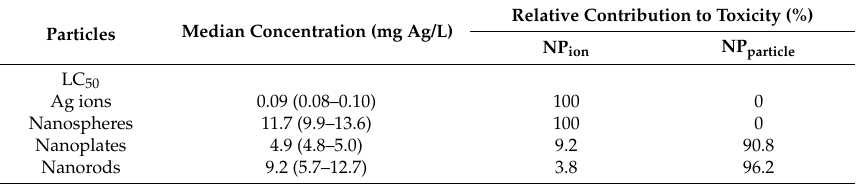
Table 2. Relative contribution (%) of AgNP ion and AgNP particle to toxicity at the LC 50 (lethality) level. LC 50 concentrations are presented as median concentration (95% confidence interval) and n = 3.